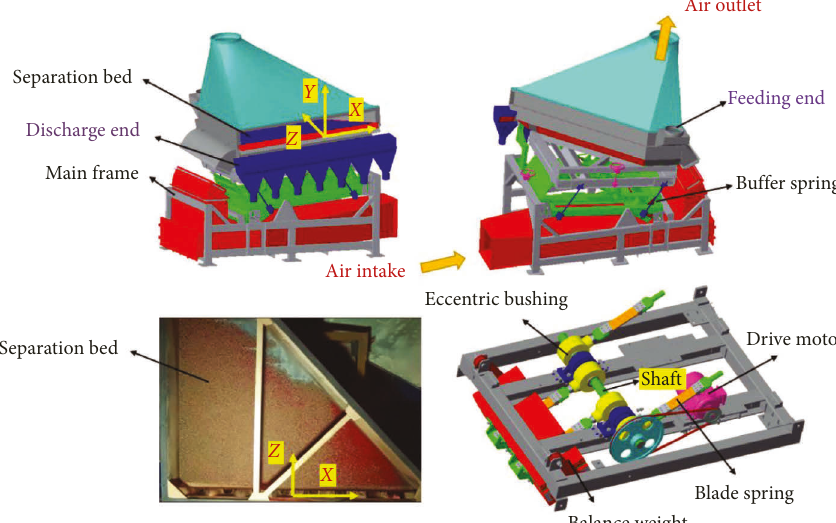
Figure 1: Structure of the novel compound dry separator (NCDS).